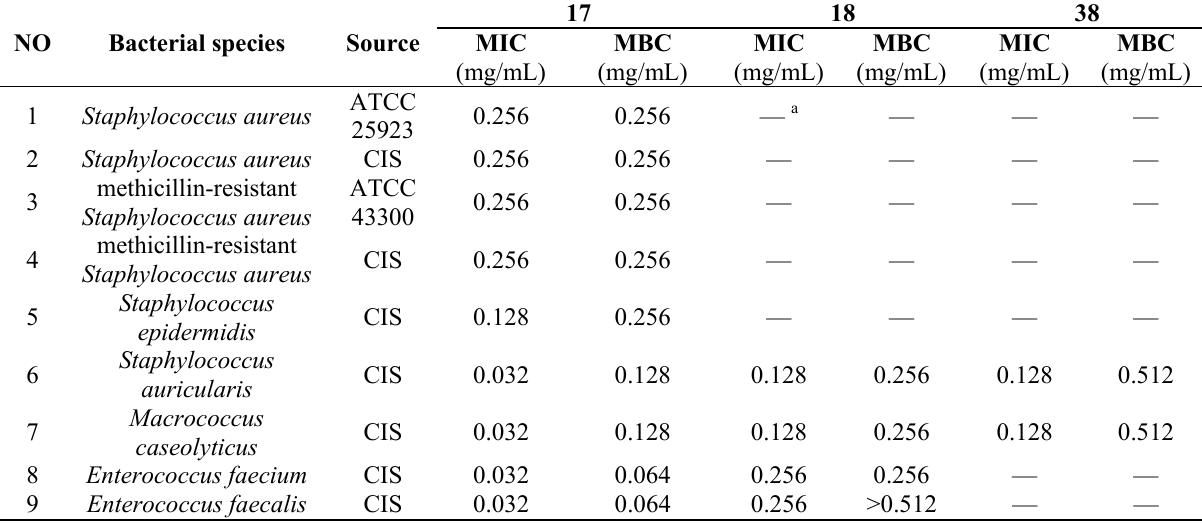
Table 3. Antibacterial activity of compounds 17 , 18 and 38